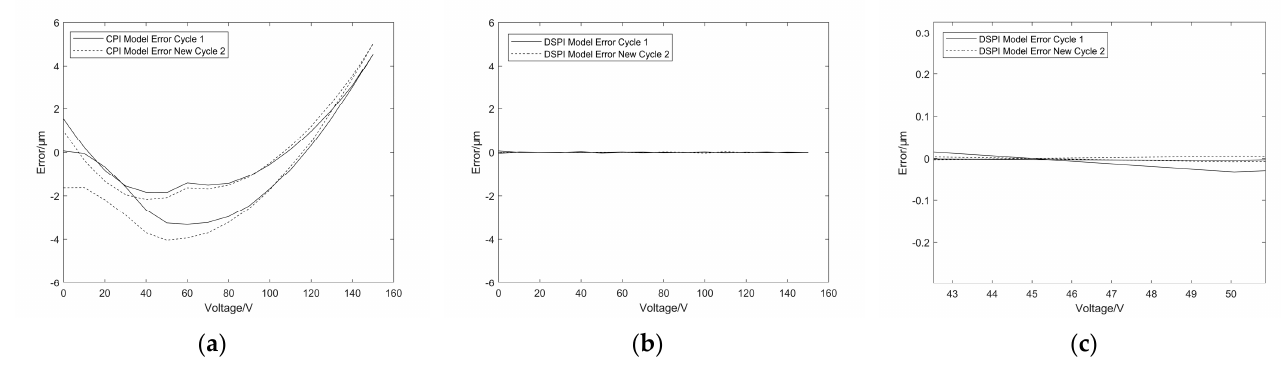
Figure 20. Modeling errors: ( a ) CPI model; ( b ) DSPI model; ( c ) local enlargement of ( b ).